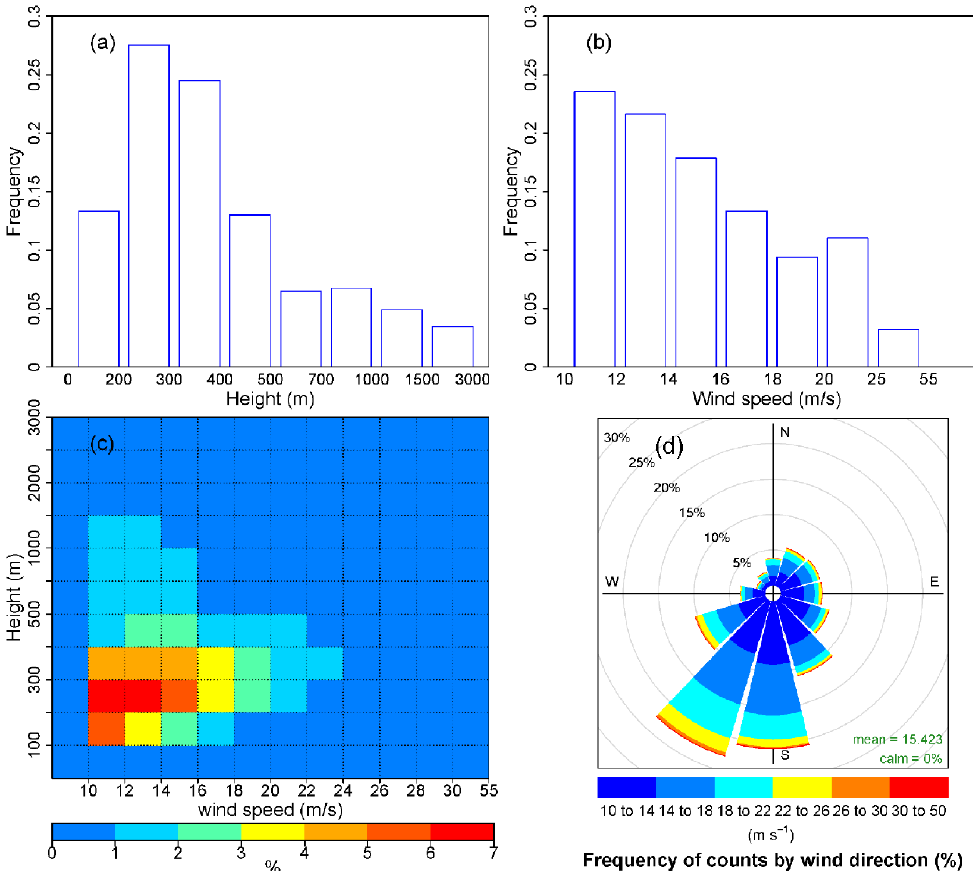
Figure 5. Low-level jets statistics over the Bohai Sea and Yellow Sea during April, May, and June (1979–2013): ( a ) Jet height histogram (%), ( b ) jet wind speed histogram (%), ( c ) jet height-wind speed distribution, and ( d ) jet wind rose [6], © Copyright 2018 American Geophysical Union (AGU). Tropical cyclones affect large parts of tropical coastal areas worldwide and their inhabitants.